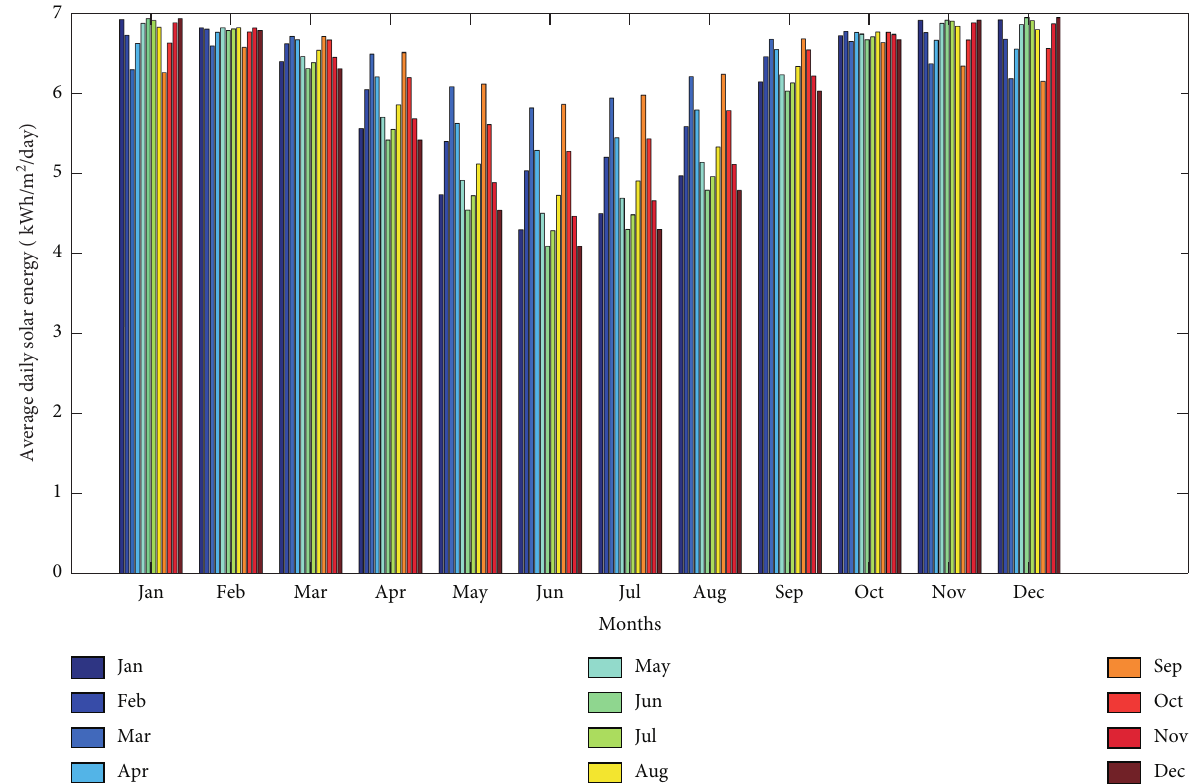
Figure 5: Monthly average daily solar energy bar graph for different optimized tilt